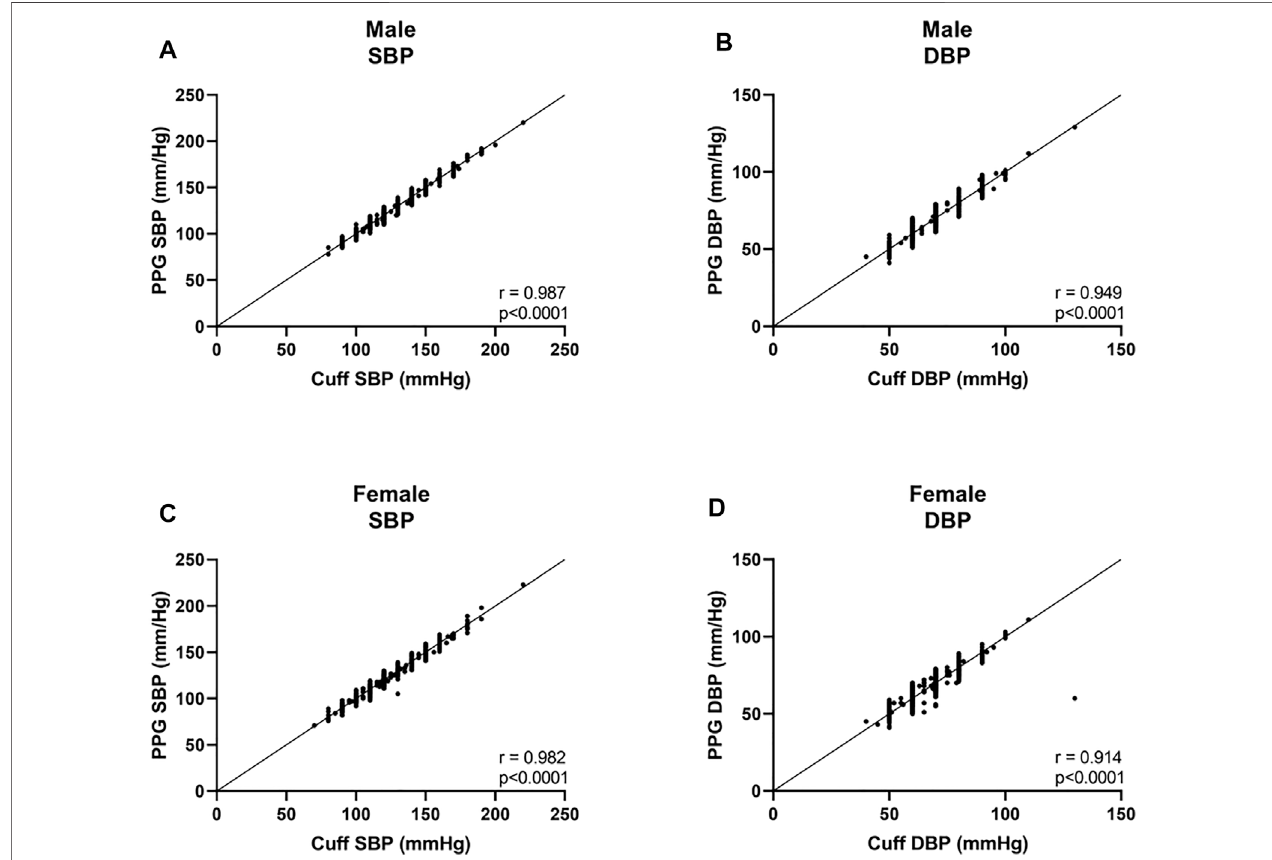
FIGURE 2 | Correlation curves of males and females. SBP systolic blood pressure, DBP, diastolic blood pressure.